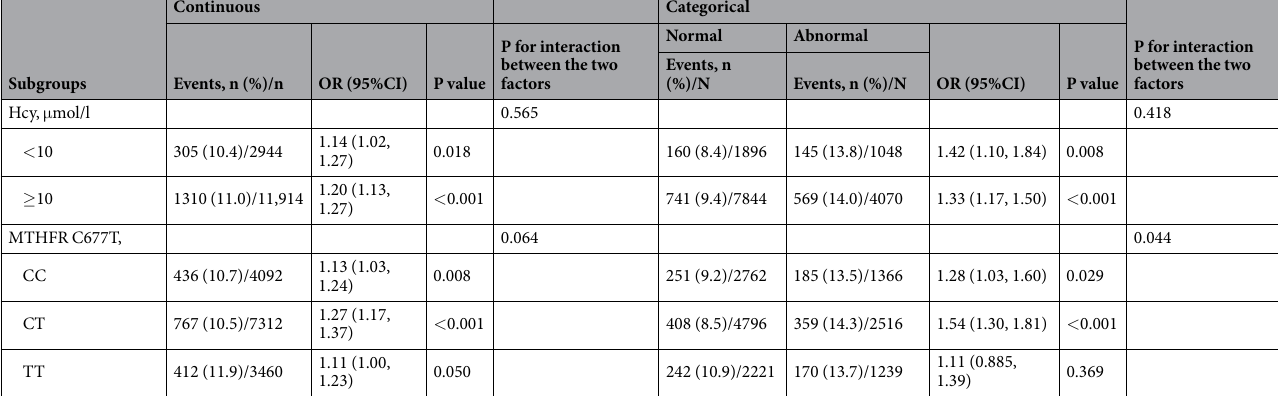
Table 3. Subgroup analysis of NOD risk associated with TG according to covariates by logistic regression. Abbreviations: SBP = systolic blood pressure, DBP = diastolic blood pressure, TG = triglycerides, HDL = high-density lipoprotein, TC = total cholesterol, HCY = homocysteine, NOD = new-onset diabetes. MTHFR = methylenetetrahydrofolate reductase. Adjusted for age, gender, clinical center, SBP, DBP, smoking and drinking status, baseline FPG, and BMI, if not stratified. Only TG levels were analyzed because of colinearity with TC and